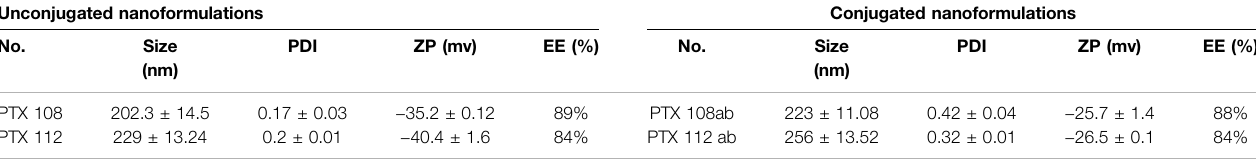
TABLE 5 | Particle size, PDI, and zeta potential of nanoformulations before and after surface modi fi cation. Unconjugated nanoformulations Conjugated